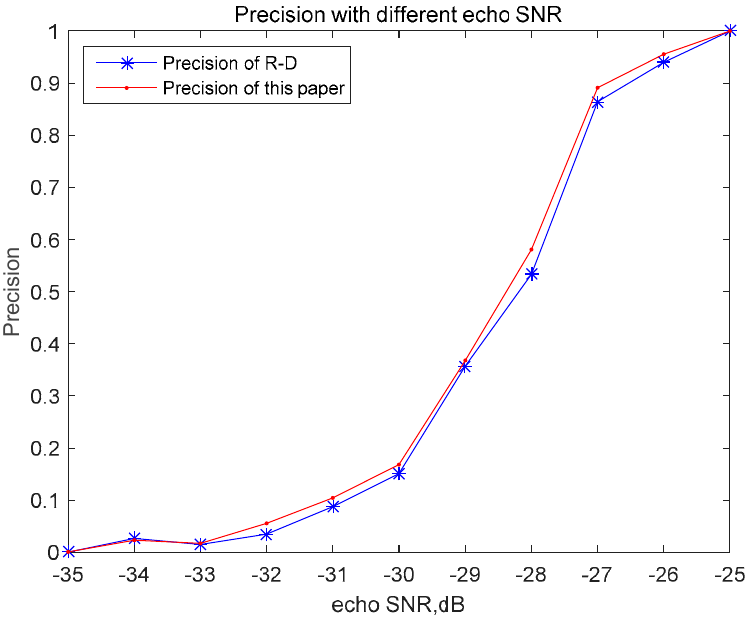
Figure 4. Difference between the target peak and the average noise platform ( N = 10 4 ).